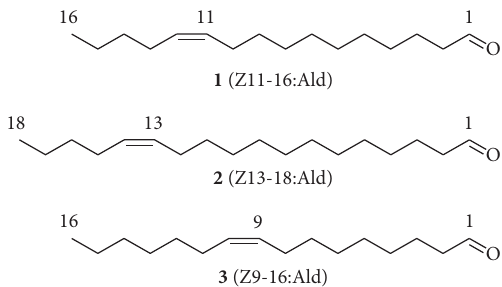
Figure 1: Sex pheromone components of rice stem borer, Chilo suppressalis